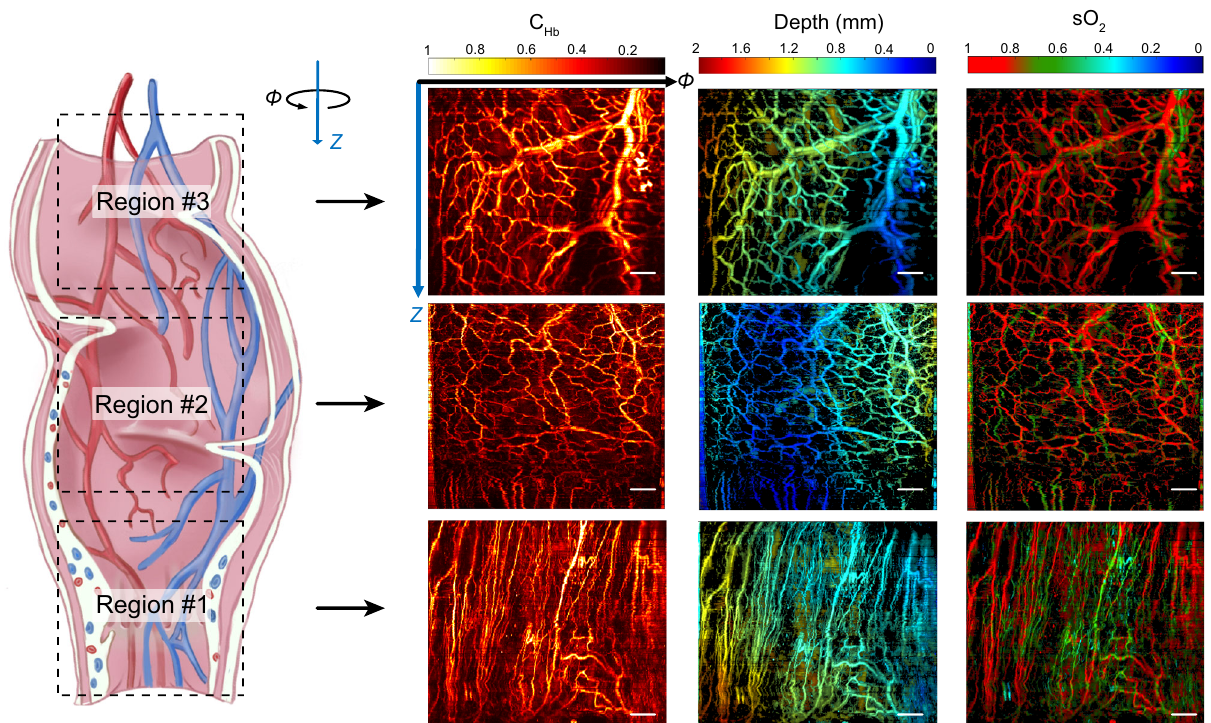
Fig. 3 | In vivo endoscopy imaging results of the hemoglobin concentration (C Hb ), depth, and oxygen saturation (sO 2 ) of a rat rectum in three different regions. The experiment was repeated six times with similar results. Scale bar: